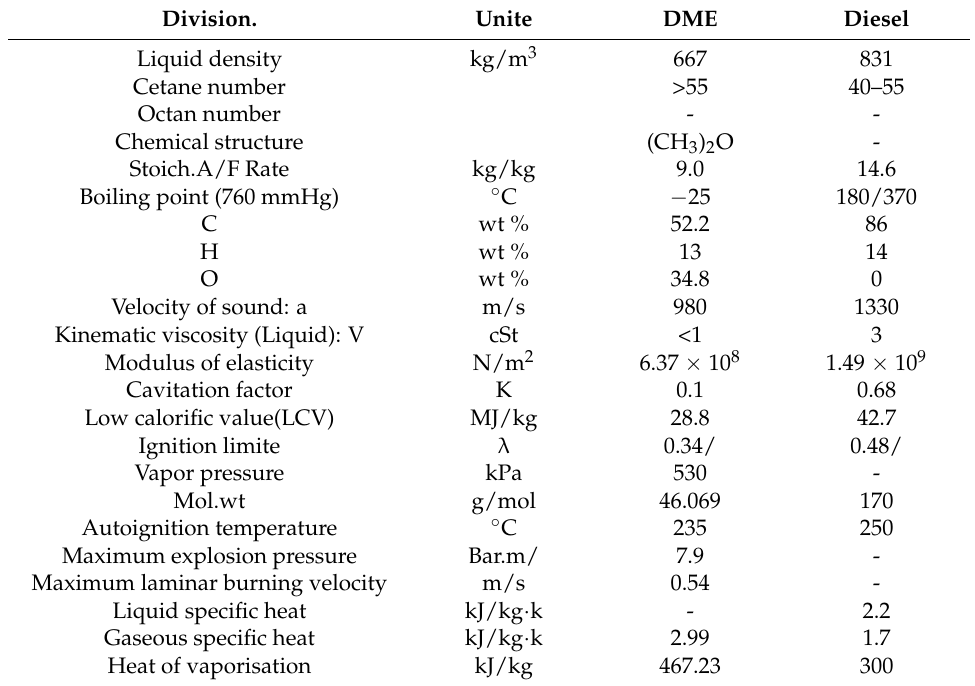
Table 2. Properties of DME and diesel